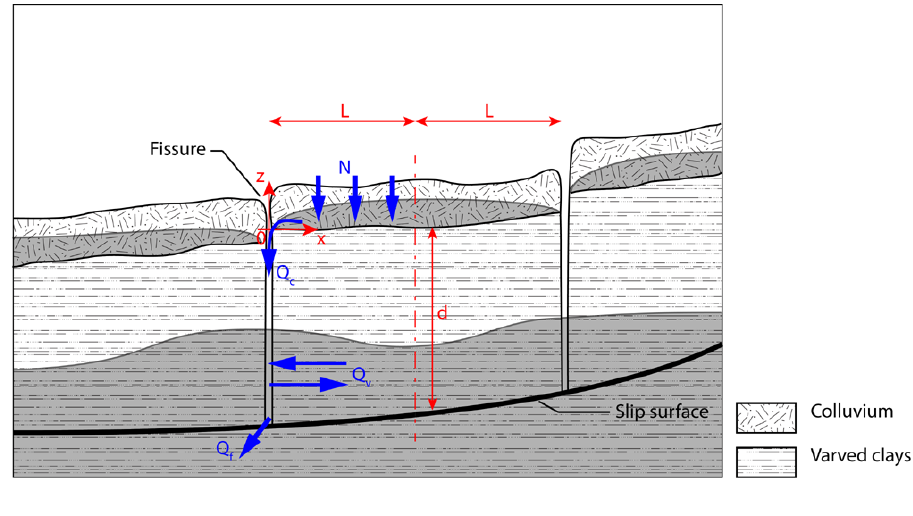
Fig. 2. Conceptual cross section of the varved clay landslides and the fluxes between the subsystems: areal recharge ( N) , outflow from the colluvium into the fissure ( Q c ) , flow from the fissure into the varved clays ( Q v ) or vice versa, and outflow from the fissure into the fissure network ( Q f ) normal to the plane of flow.